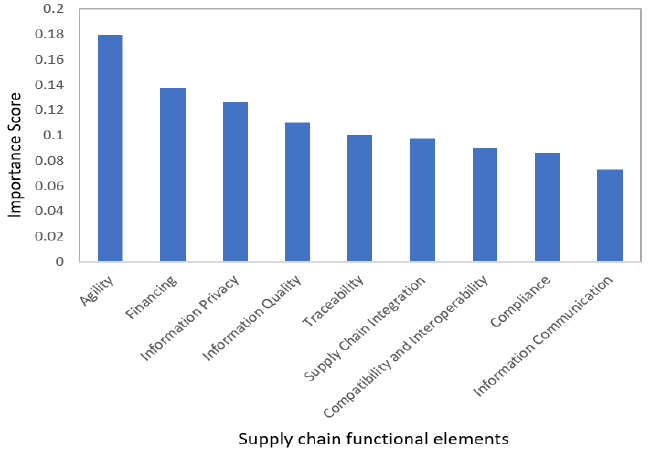
Figure 6. Supply chain functional elements based on their importance for ICT adoption.